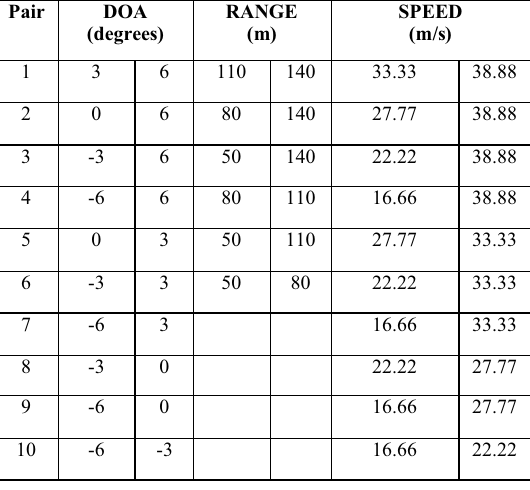
TABLE V. P AIRS OF RANGES , ANGLES , AND SPEEDS TRUCK